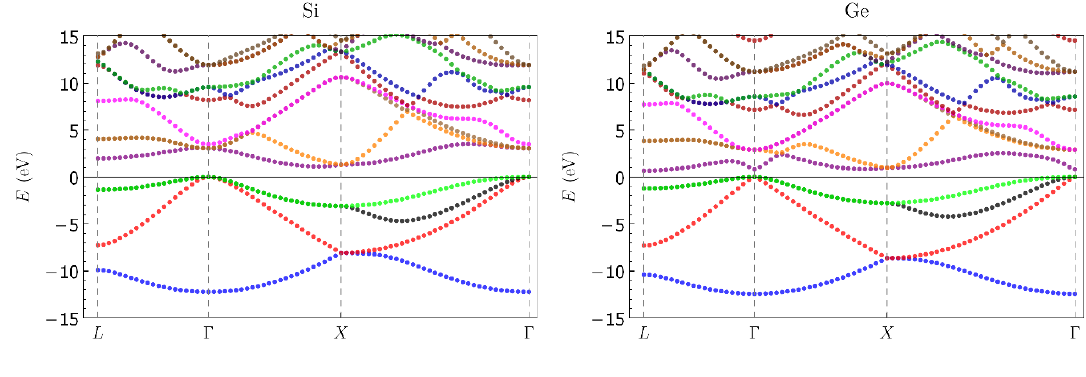
Figure 3 . The scissor corrected band structures of silicon ( left ) and germanium ( right ) along the Brillouin zone path L -Γ- X -Γ, respectively. The calculations are performed using the ABINIT package [32], based on the PAW data sets output from the atompaw code [30]. The top of the valence bands are rescaled to 0 eV, while the dotted lines above the horizontal lines represent eleven lowest conduction bands. See text for